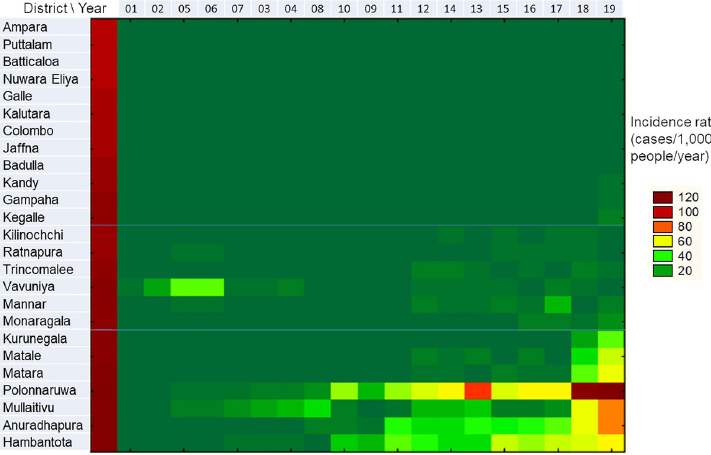
Fig 4. Joining classification of study areas and study period by incidence rate at each